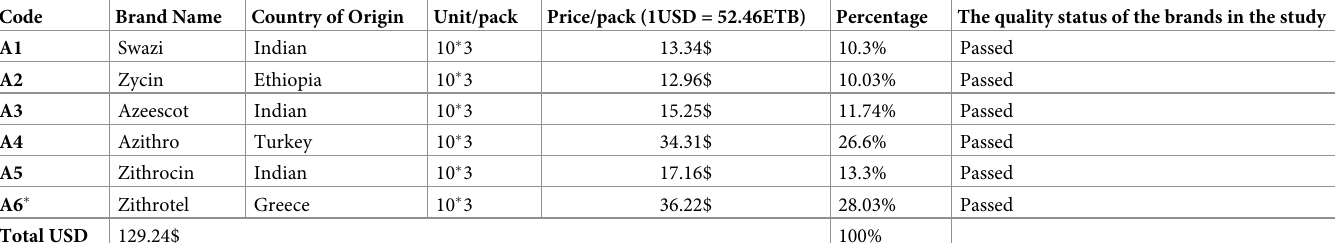
Table 14. The comparison of the price vs the quality of azithromycin brands.